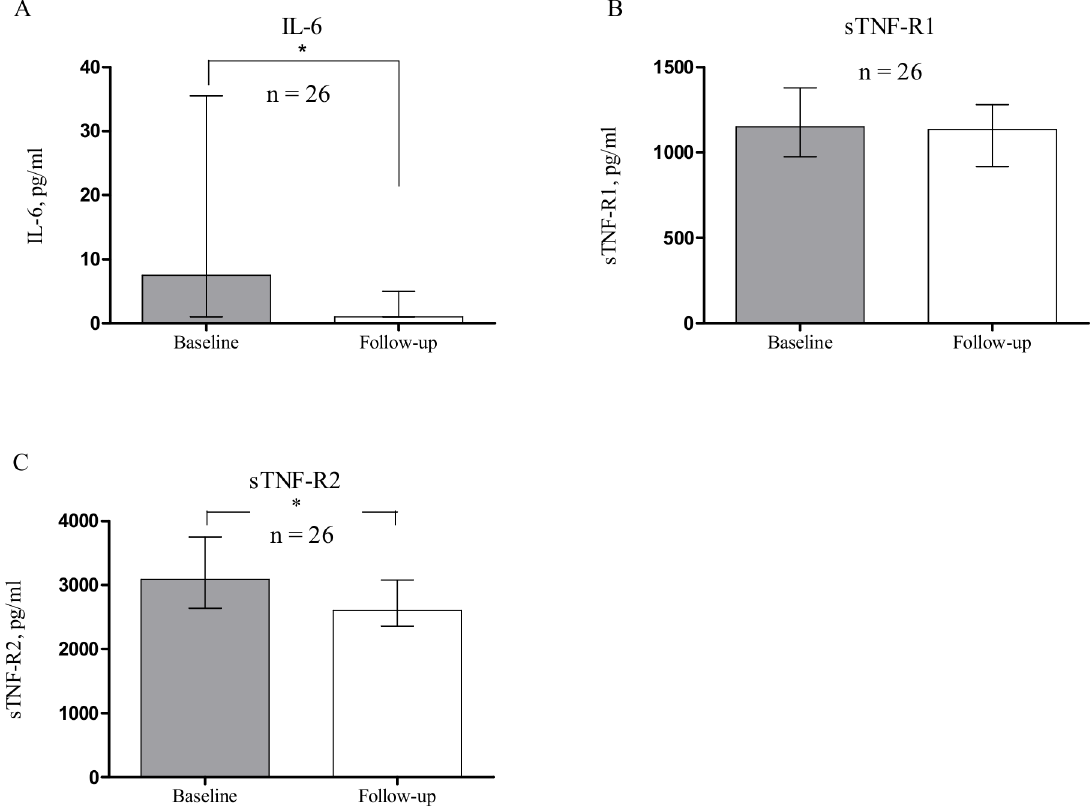
Fig 2. Changes in levels of IL-6, sTNF-R1 and sTNF-R2 following 6 months of treatment with adalimumab or infliximab. Level of IL-6 and sTNF-R1 and sTNF-R2 were determined in 26 patients with rheumatoid arthritis, 15 patients treated with adalimumab, and 11 patients treated with infliximab. Levels were determined prior to treatment (Baseline) and following 6 months of treatment (Follow-up). Levels of IL-6 (A) and sTNF-R2 (C) decreased significantly during treatment. * p < 0.05. Medians and interquartile ranges are